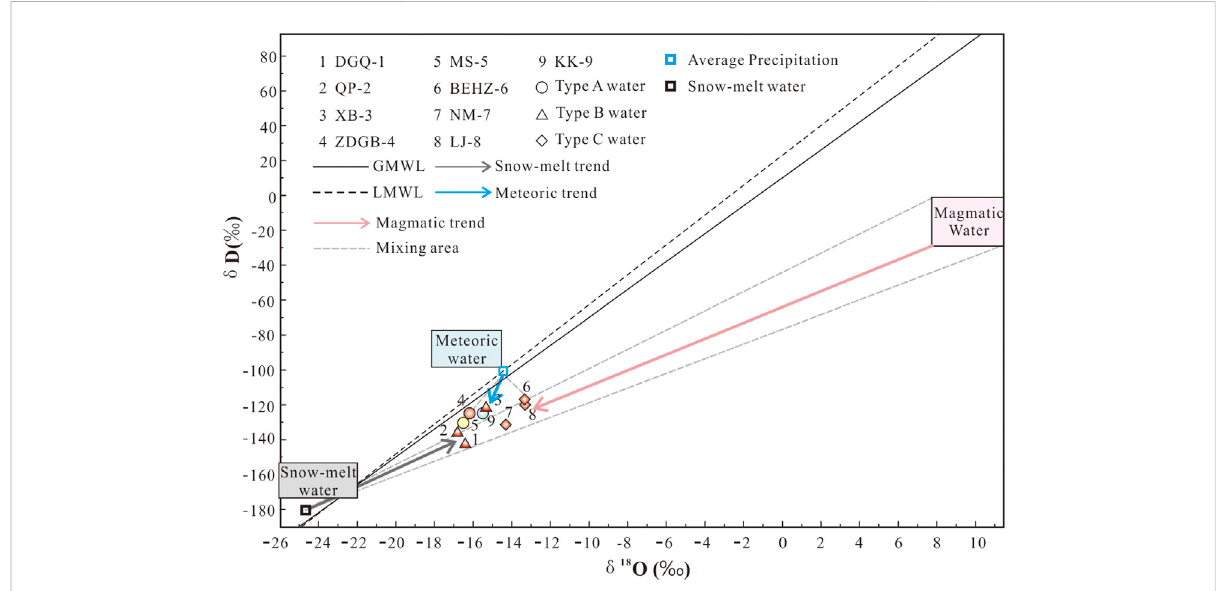
FIGURE 3 Plot of stable oxygen and hydrogen isotopes of spring water samples from the KKF. The straight line ( δ D = 8.0 δ 18 O + 10.0; Craig, 1961) representstheglobalmeteoricwaterline(GMWL),andthedashedline( δ D=7.93 δ 18 O+11.59) representsthelocalmeteoricwaterline (LMWL)atthe Gangotri station, India. V-SMOW = Vienna Standard Mean Ocean Water. The legend is the same as in Figure